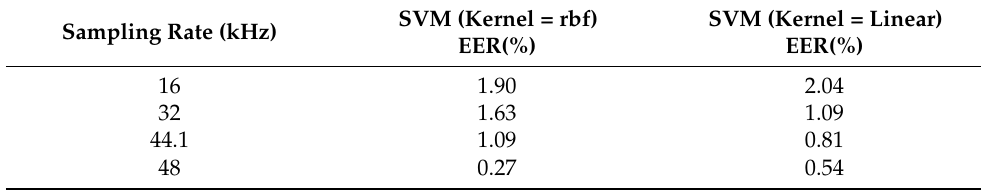
Table 3. The performance under different sampling rates.